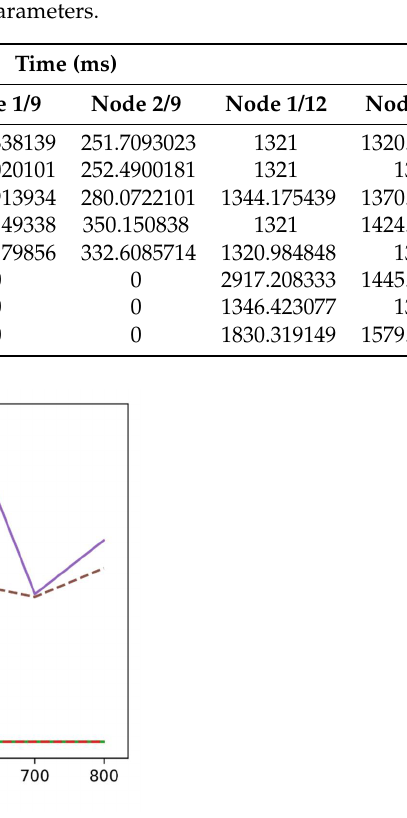
Figure 9. Comparison of delay graph from changing parameters of spreading factor.